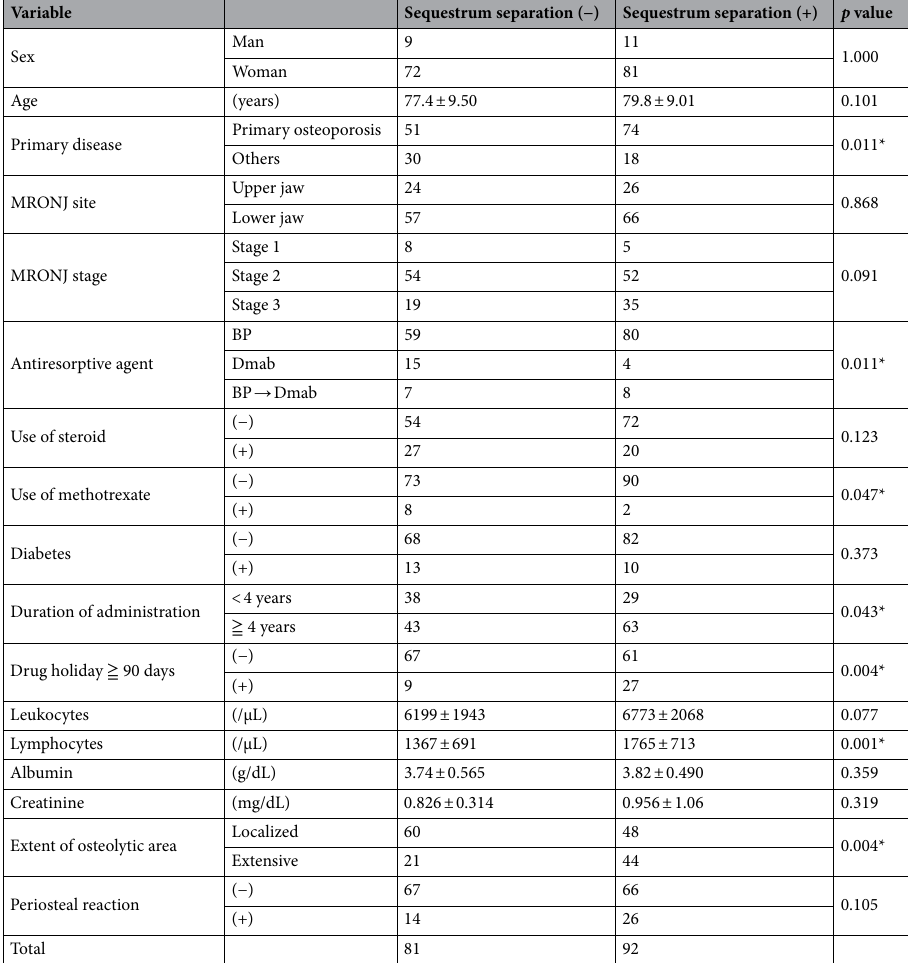
Table 2. Relationship between each variable and sequestrum separation (univariate analysis). *Significant. BP: bisphosphonate, Dmab: denosumab.